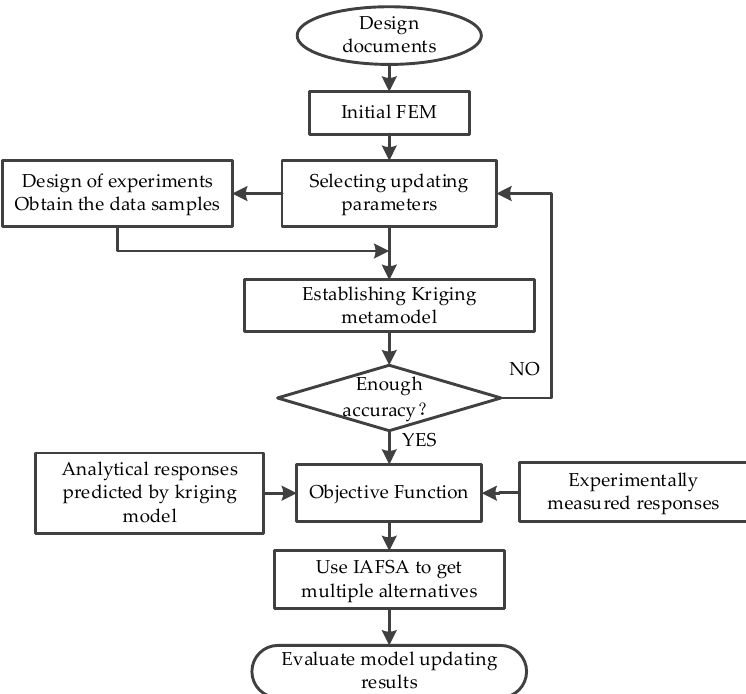
Figure 3. The research flow of multi-alternatives problem in finite element model updating (FEMU).